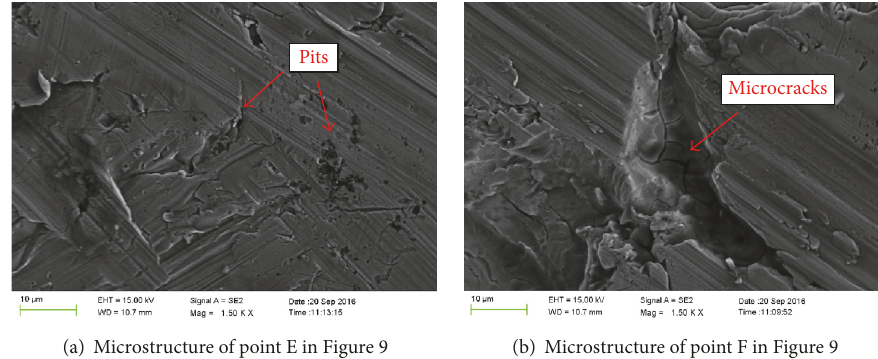
Figure 11: Microstructure of KMN-I tensile-bending fatigue specimen.